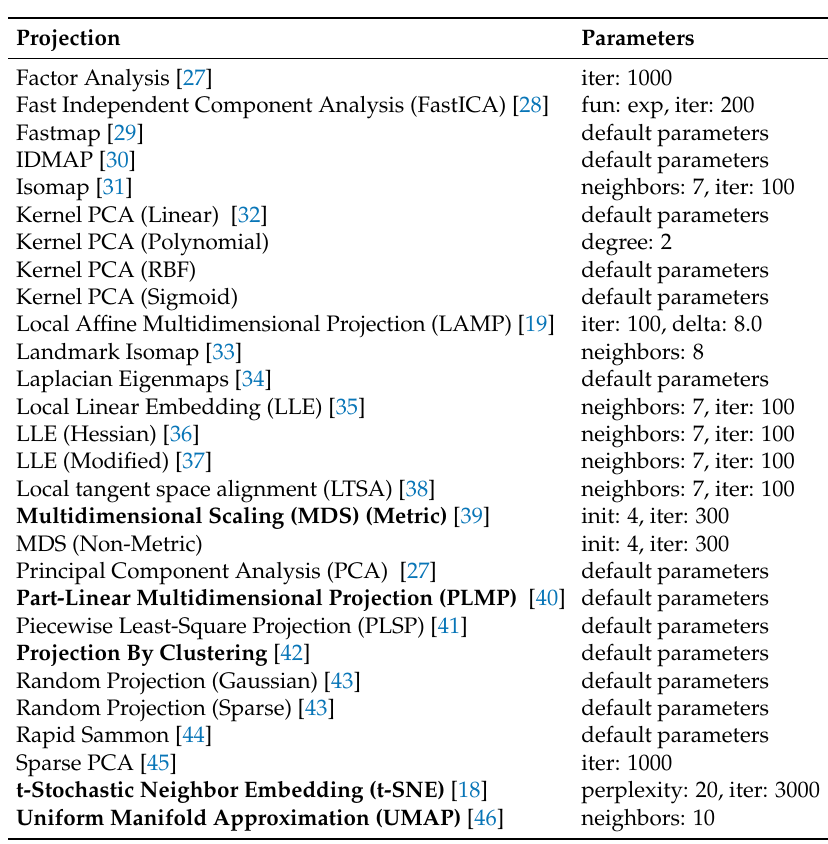
Table 2. Projections tested in phase 1 (Section 4.2). Projections tested in phase 2 (Section 4.2) are marked in